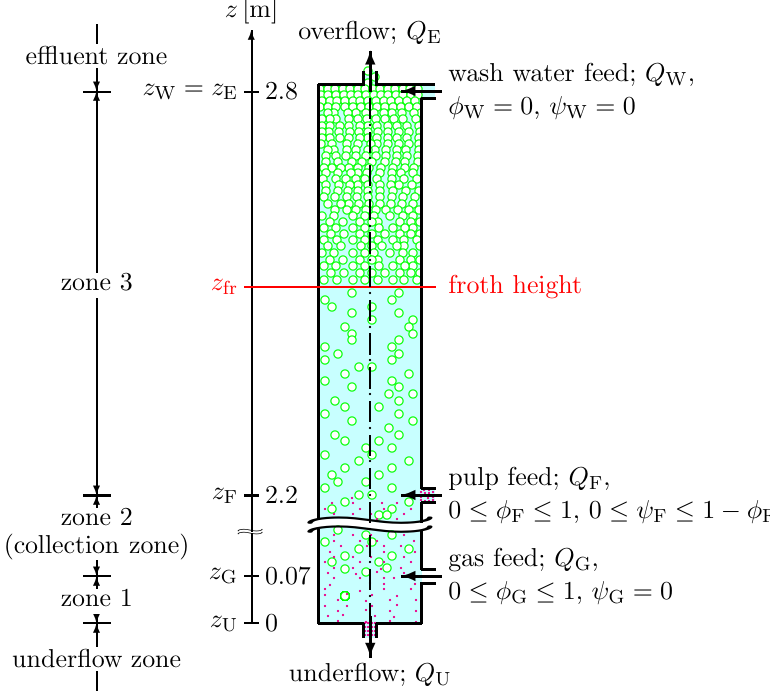
Figure 1. Conceptual drawing of the model of the pilot flotation column: ( left ) denomination of zones, ( middle ) height axis ( z -axis) showing the locations of the feed and discharge levels and ( right ) schematic of the column. The green open circles and solid magenta dots represent bubbles and hydrophilic particles (bubbles and particles are not drawn to scale), respectively. The information to the right indicates the overflow rate, volume feed rates and concentrations and the underflow volume rate along with limitations that the feed concentrations must satisfy. The denomination of zone 2 as a “collection zone” is common in mineral processing, although the process of collection (the adhesion of hydrophobic particles to bubbles) is not part of the